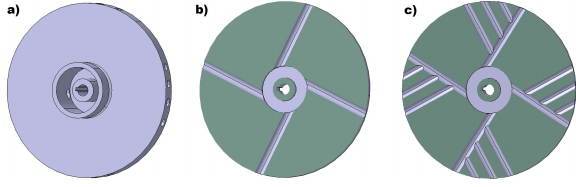
Figure 1: The hole impeller (a) top view, (b) basic hole impeller and (c) hole impeller with accessory additional branch channels